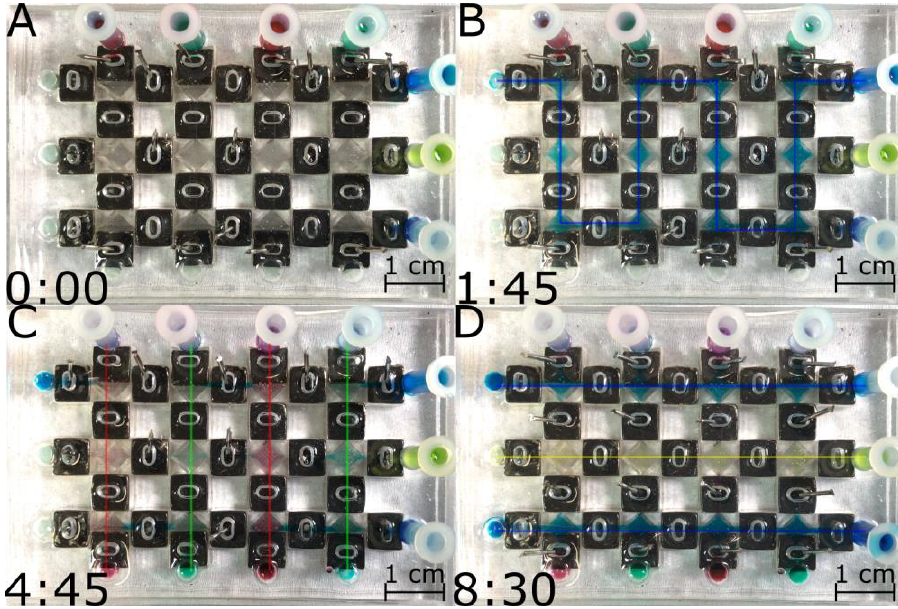
Figure 4. Screen captures from a video (see Supplementary Video S1) illustrating a typical flow rerouting experiment inside a SCCA ( A ) Device before loading at t = 0 min; ( B ) Loading of the device with blue dye through one inlet (top right) and one outlet (top left) at t = 1.75 min; ( C ) Vertical loading (top to bottom) of the device with red and green dyes at t = 4.75 min; ( D ) Horizontal loading (right to left) of the device with blue and yellow dyes at t = 8.5 min. The arrows indicate the direction of the flow in the channel and the color of the aqueous solution used.